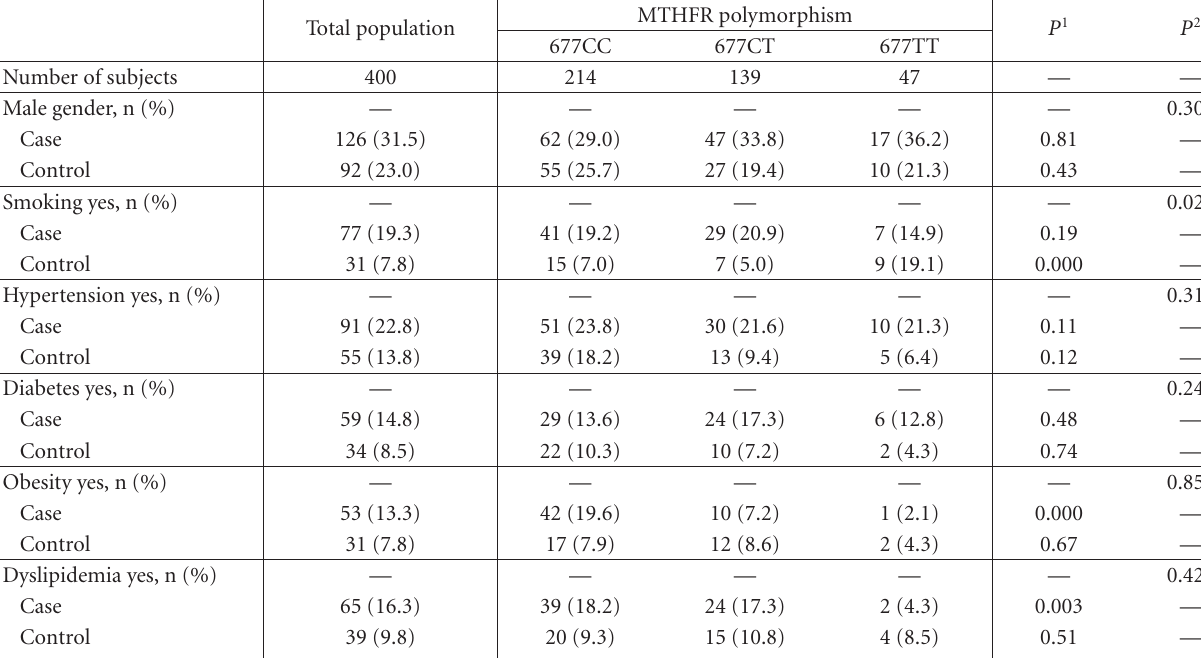
Table 4: Traditional risk factors distribution according to MTHFR polymorphism and CAD. 677CC, 677CT, and 667TT are the wild-type, the heterozygous, and the mutant genotypes. Comparison of traditional risk factors between MTHFR genotypes ( chi-square test ), in cases and controls separately ( P 1 ) and in all subjects ( P 2 ).